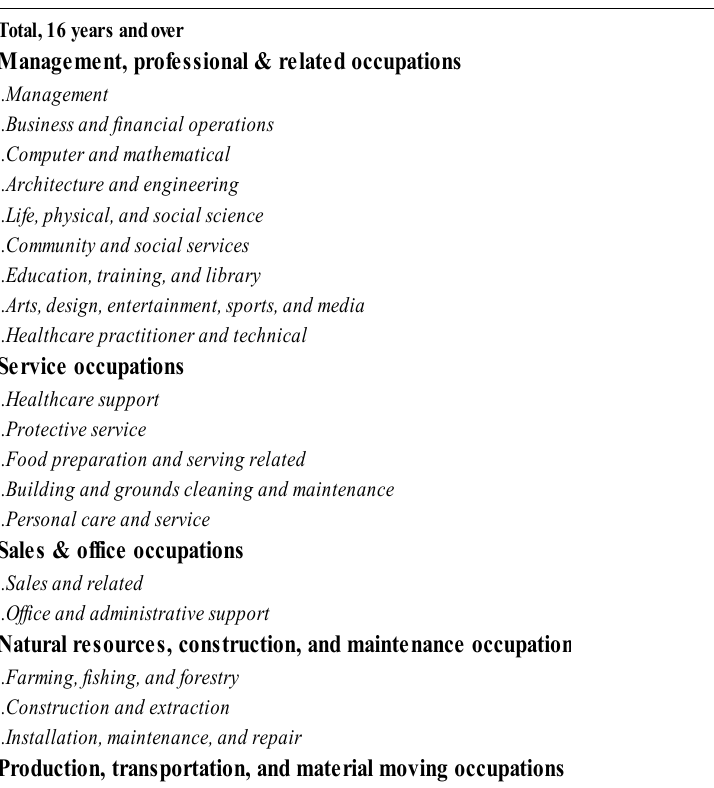
Table I: Distribution of United States occupational employment, adjusted for cost of trust [22]